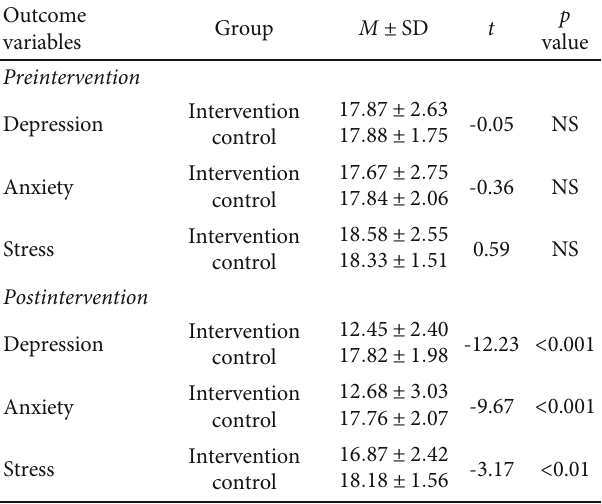
Table 2: Independent samples t -tests between the intervention and control groups pre- and